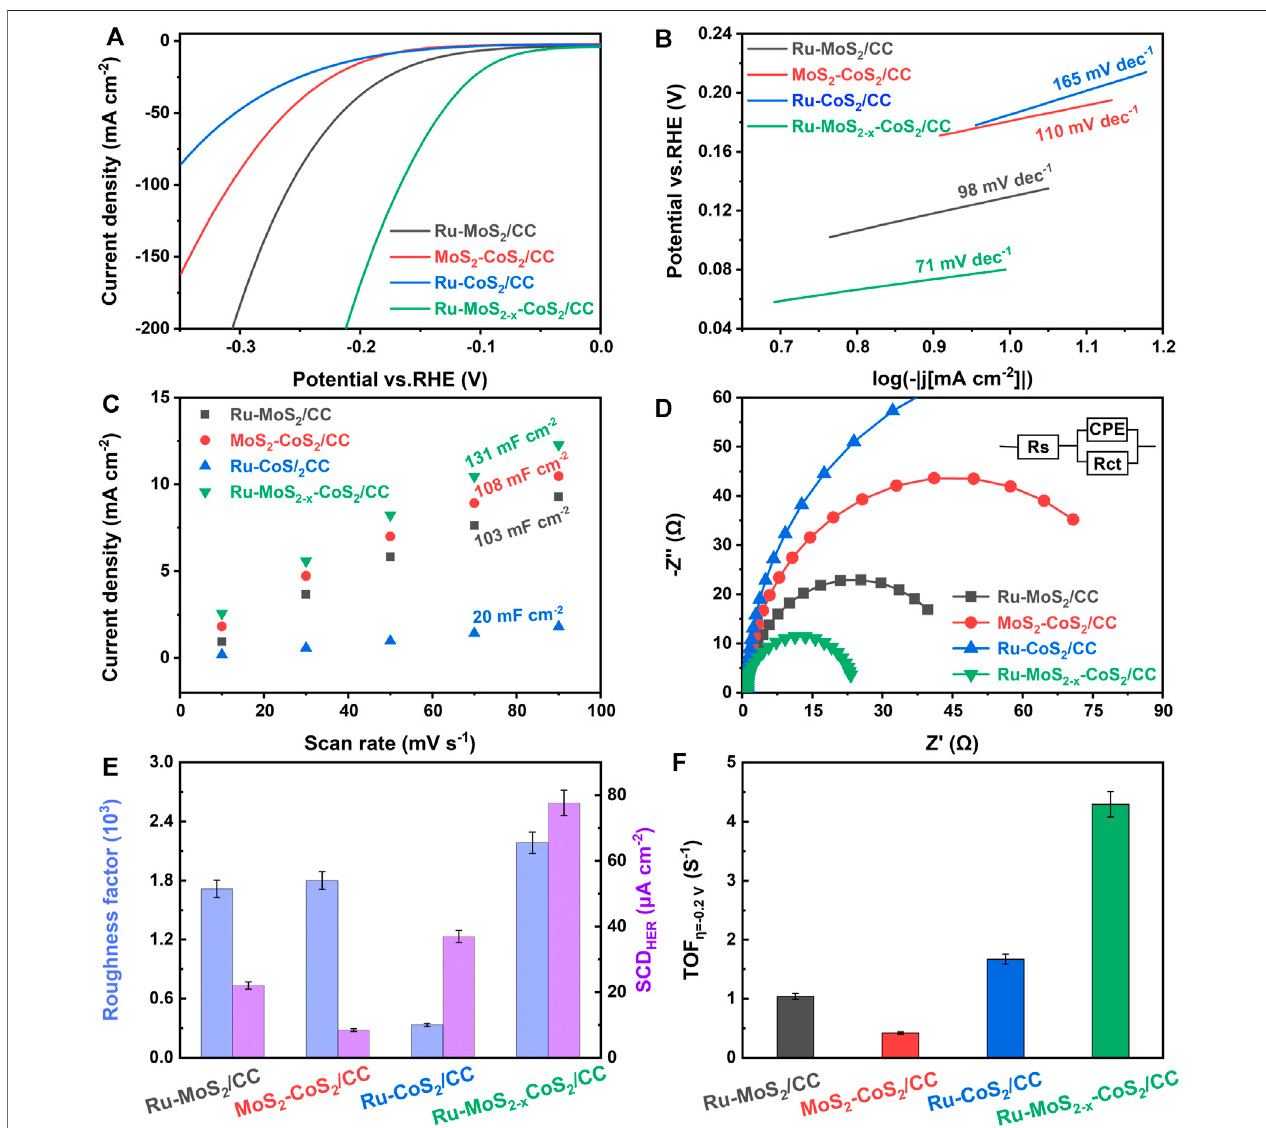
FIGURE8|(A) Polarizationcurves, (B) Tafelplots, (C) C dl atdifferentscanrates, (D) Nyquistplots, (E) R f andSCD HER ,and (F) TOFat0.2VofRu-MoS 2 /CC,MoS 2 - CoS 2 /CC, Ru-CoS 2 /CC, and the typical samles. The electrolyte is N 2 -saturated 1 M KOH.